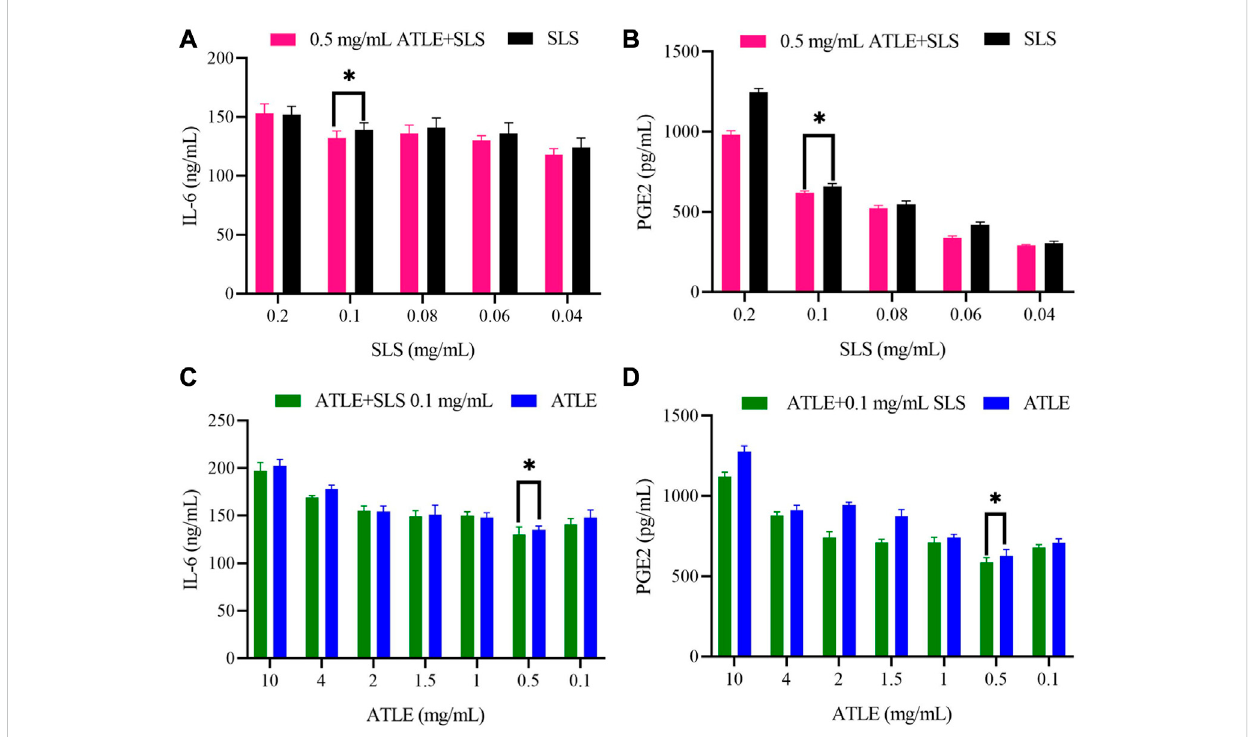
FIGURE 4 Interleukin 6 (IL-6) and prostaglandin E2 (PGE2) level in supernatant of SLS, 0.5 mg/mL ATLE-SLS, ATLE, and ATLE-0.1 mg/mL SLS treated HaCaT cells. (A) The released IL-6 levels in only the SLS group and 0.5 mg/mL ATLE-SLS group were measured with IL-6 Elisa Kit. (B) The released PGE2 levels in only the SLS group and 0.5 mg/mL ATLE-SLS group were measured with the PGE2 Assay Kit. (C) The released IL-6 levels in only the ATLE group and ATLE-0.1 mg/mL SLS group were measured with IL-6 Elisa Kit. (D) The released PGE2 levels in only theATLE group and ATLE-0.1 mg/mL SLS group were measured with the PGE2 Assay Kit. * p <